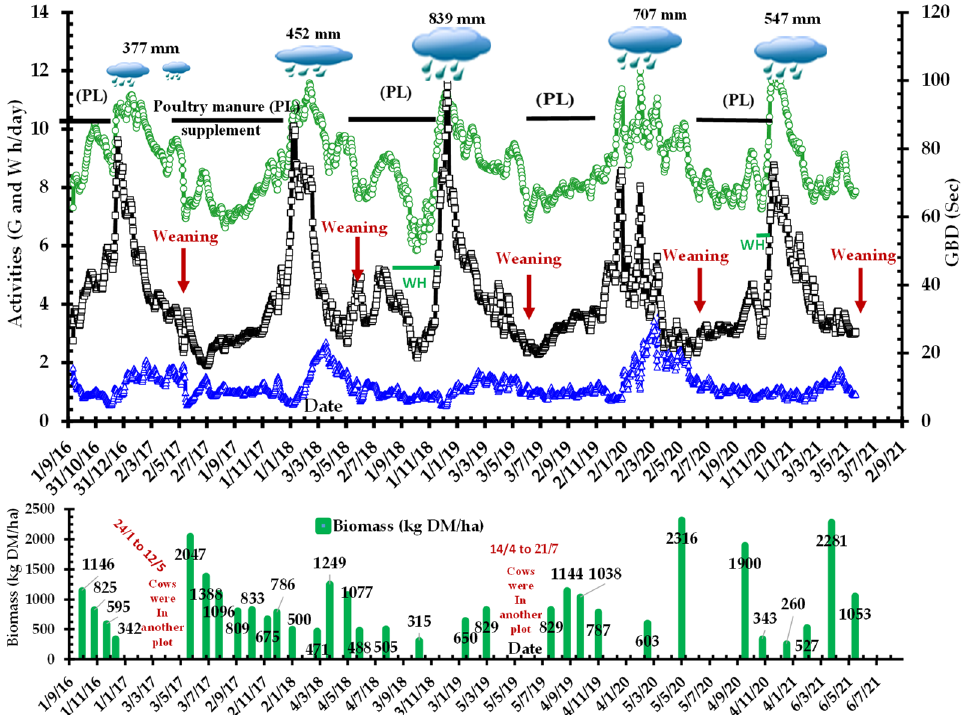
Figure 5. The study plot, biomass (kg DM/ha, direct sampling), yearly seasonal winter rain, duration of poultry manure supplementation (PL ꟷ ) and of wheat hay supplementation (WH ꟷ ), and cows’ weaning events. Cows’ daily walking (W, h/day, ∆ ) and grazing (G, h/day, o), and the average daily grazing bout duration (GBD, □ ). Dates are given as day/month/year. Weaning dates: 9 April 2017,